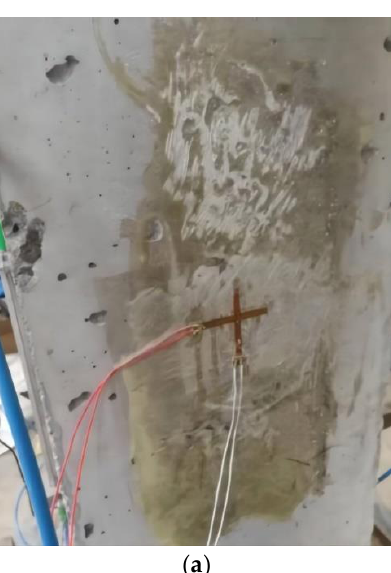
Figure 5. Installation diagram of FBG strain sensor: ( a ) front side and ( b ) rear side.